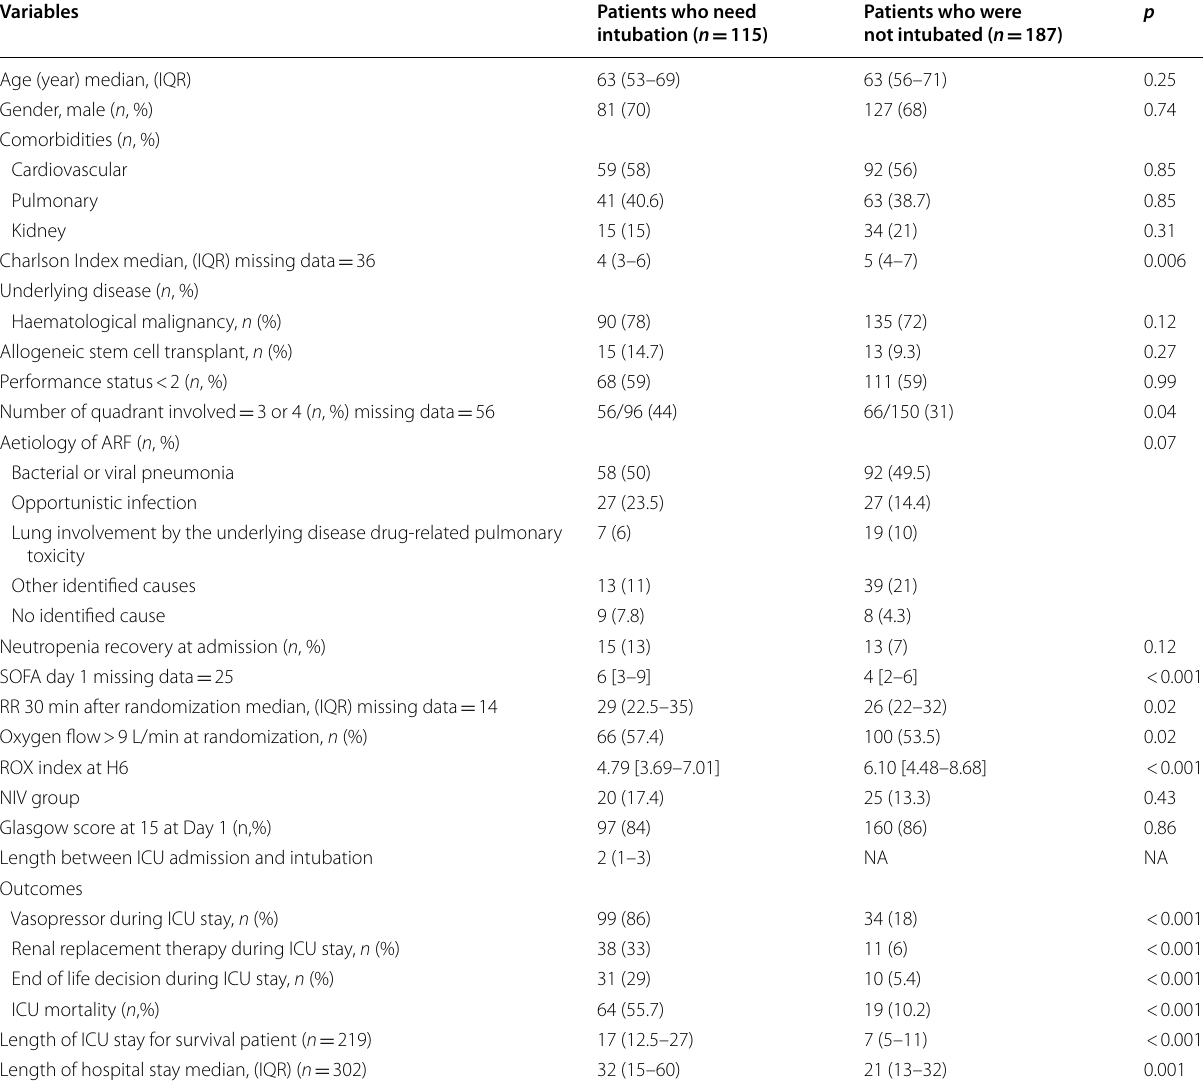
Table 1 Characteristics and outcomes based on the need for